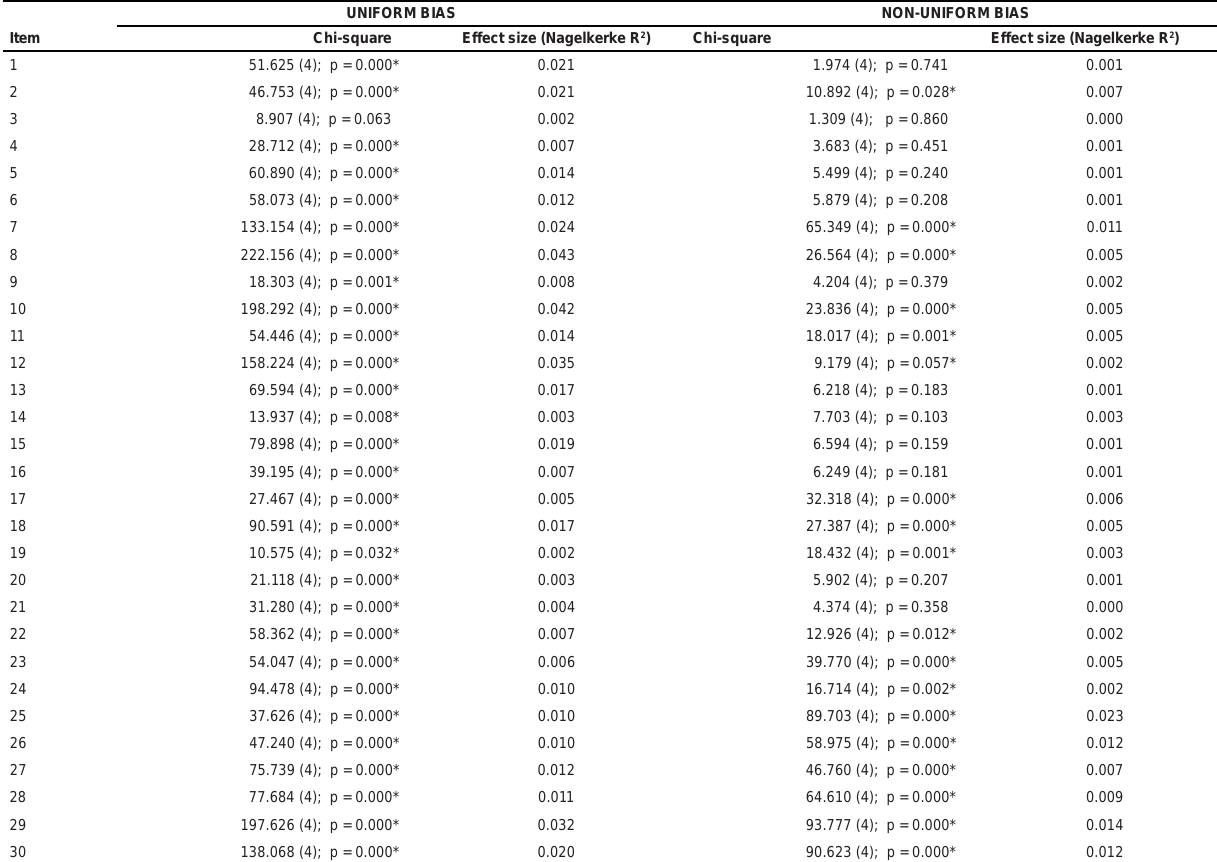
table 6 Item-bias statistics of the conceptual-reasoning test for the different language